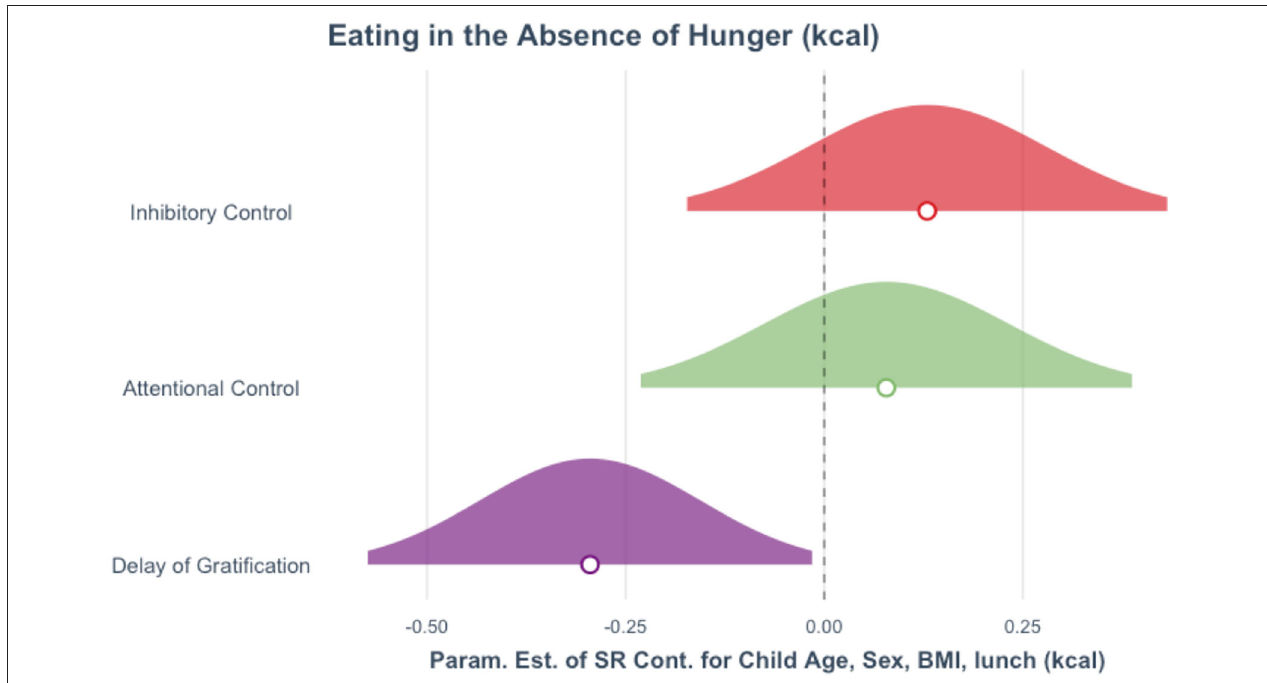
FIGURE 4 | Visualization of the effects of self-regulation on eating in the absence of hunger (EAH) by self-regulation (SR) domain, controlling for child age, child sex, child BMI, and the number of calories (kcal) consumed during the lunch test meal. Each curve represents the 95% confidence interval, circles represent the standardized parameter estimates for inhibitory control ( ß = 0.130), attentional control ( ß = 0.078), and delay of gratification ( ß = − 0.295). One of the multiply imputed data sets was chosen at random for plotting purposes.